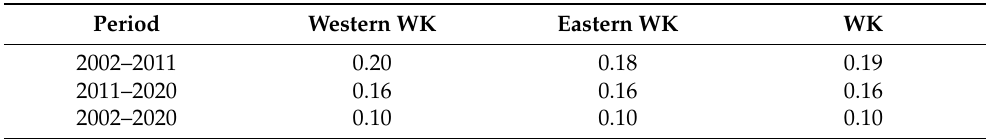
Table 7. Annual IVT (unit: kg m − 1 s − 1 a − 1 ) trends in Western WK, Eastern WK and WK over three periods. Period Western WK Eastern WK